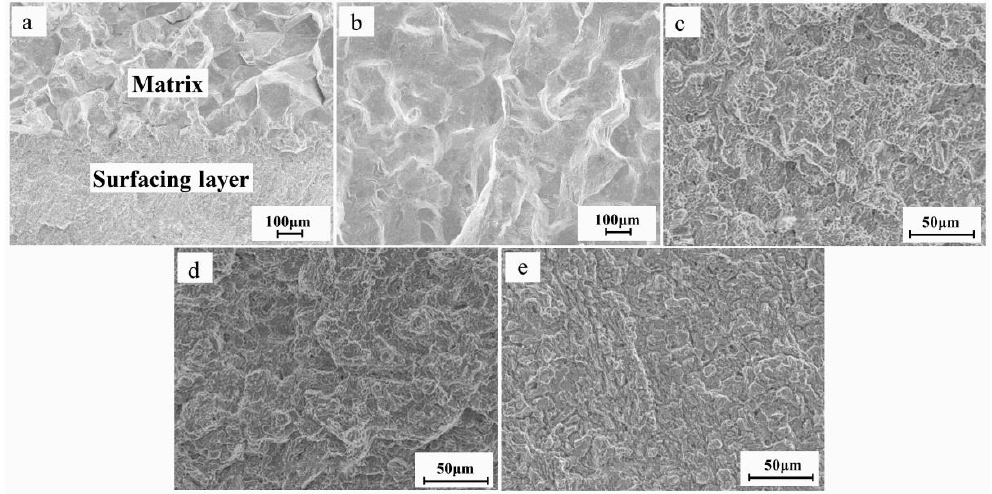
Figure 10. Impact fracture morphology of the base and different material surfacing layers. ( a ) fracture morphology of composite; ( b ) #1; ( c ) #2; ( d ) #3; ( e ) #4. Table 7. Impact energy of the matrix and different composite materials (J·cm −2 ).